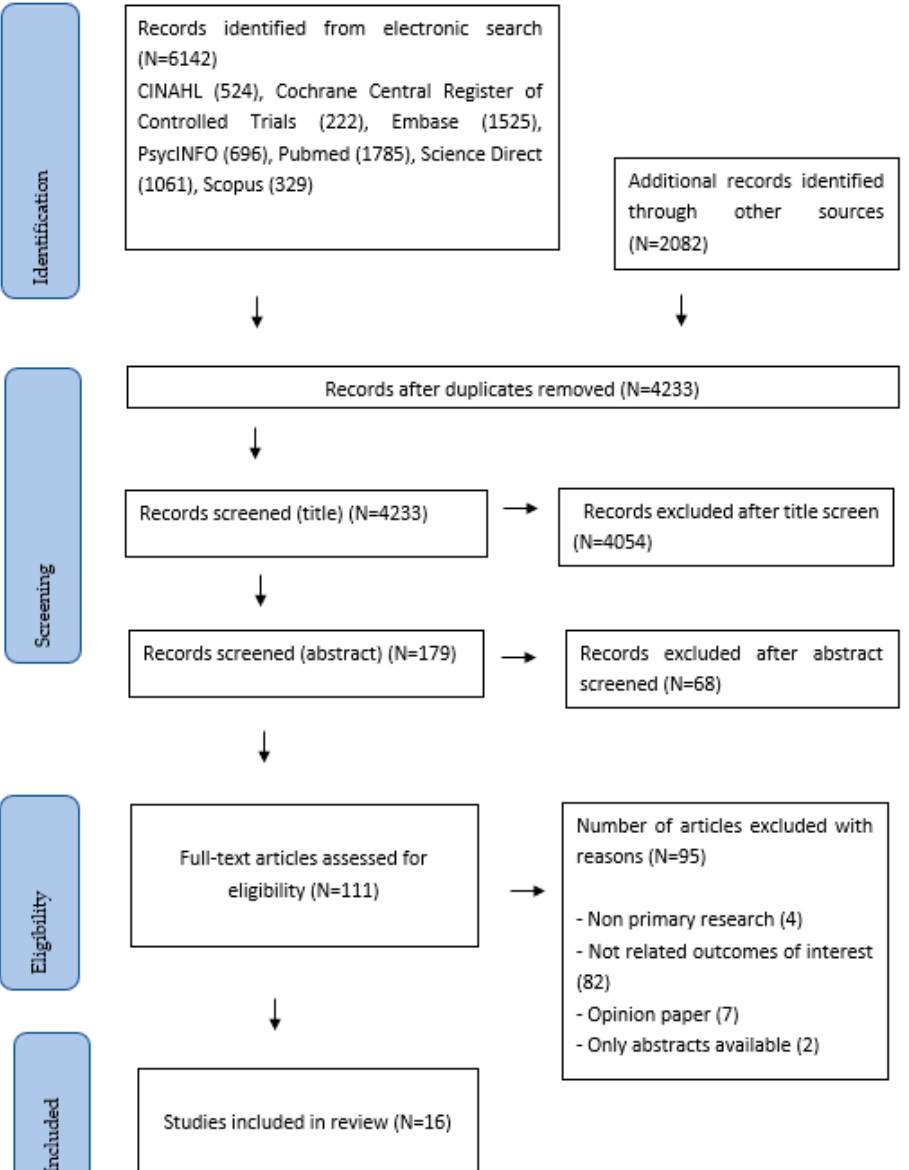
Figure 1. Search Figure 1. Search strategy.